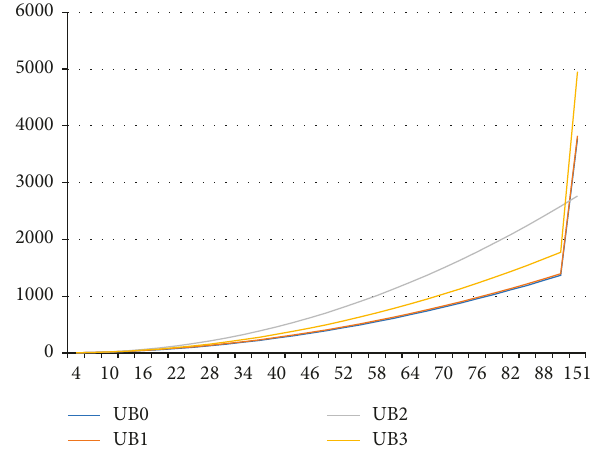
Figure 3: Comparison among UB0, Ub1, UB2, and UB3 for the radio number of triangular snake.